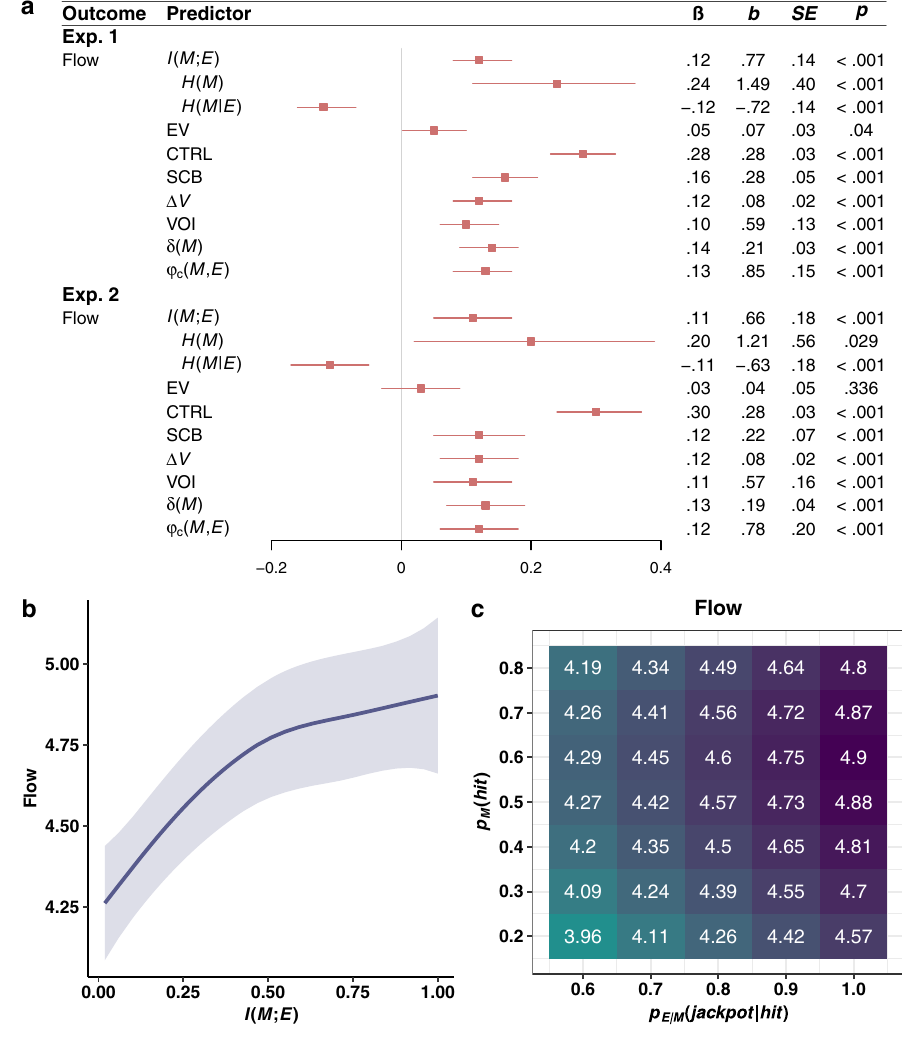
Fig. 2 Flow results from experiments 1 and 2. a Effect of all variables of interest on fl ow in experiment 1 (Exp. 1) and experiment 2 (Exp. 2). The variables of interest are I M ; E ð Þ , its constituent entropy terms H M ð Þ and H M j E ð Þ , expected value (EV), controllability (CTRL), skill-challenge balance (SCB), marginal value ( Δ V ), the value of information (VOI), temporal difference prediction error ( δ M ð Þ ), and the correlation between M and E ( φ ð M ; E Þ ). Statistics are c derived from linear mixed models (LMMs; two-sided) performed over 720 observations across 365 participants in experiment 1, and 488 observations across 249 participants in experiment 2. Each LMM regresses fl ow on one variable from the predictor column (with the exception of H M ð Þ and H ( M | E ), which are included in the same model), a nuisance regressor for game order ( fi rst game vs. second game), and random subject-level intercepts. Red squares denote standardized regression coef fi cients, and intersecting red lines represent 95% CIs. No corrections for multiple comparisons were applied. b Results of GAM showing the nonlinear, but monotonically increasing effect of I ( M;E ) on fl ow. The solid line denotes expected values and the ribbons denote 95% CIs. c GAM-derived expected values of fl ow for each combination of p M (hit) and p ð jackpot j hit Þ E j M